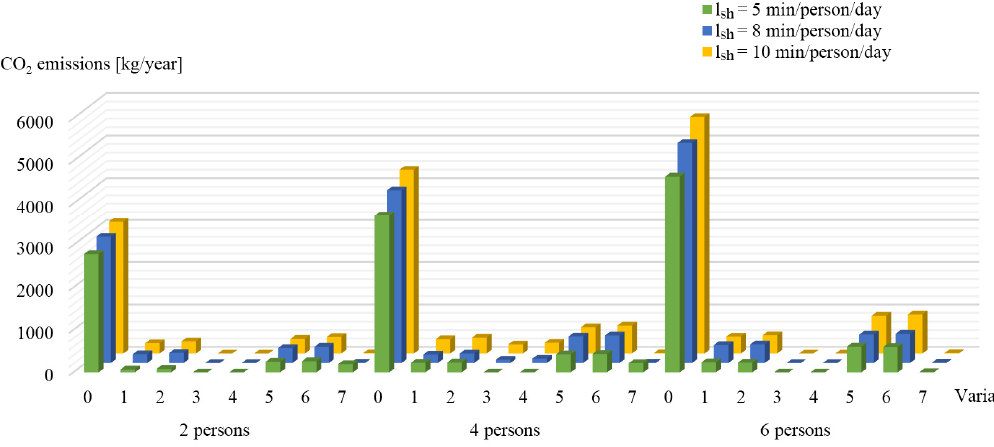
Figure 16. Annual emission of CO 2 .